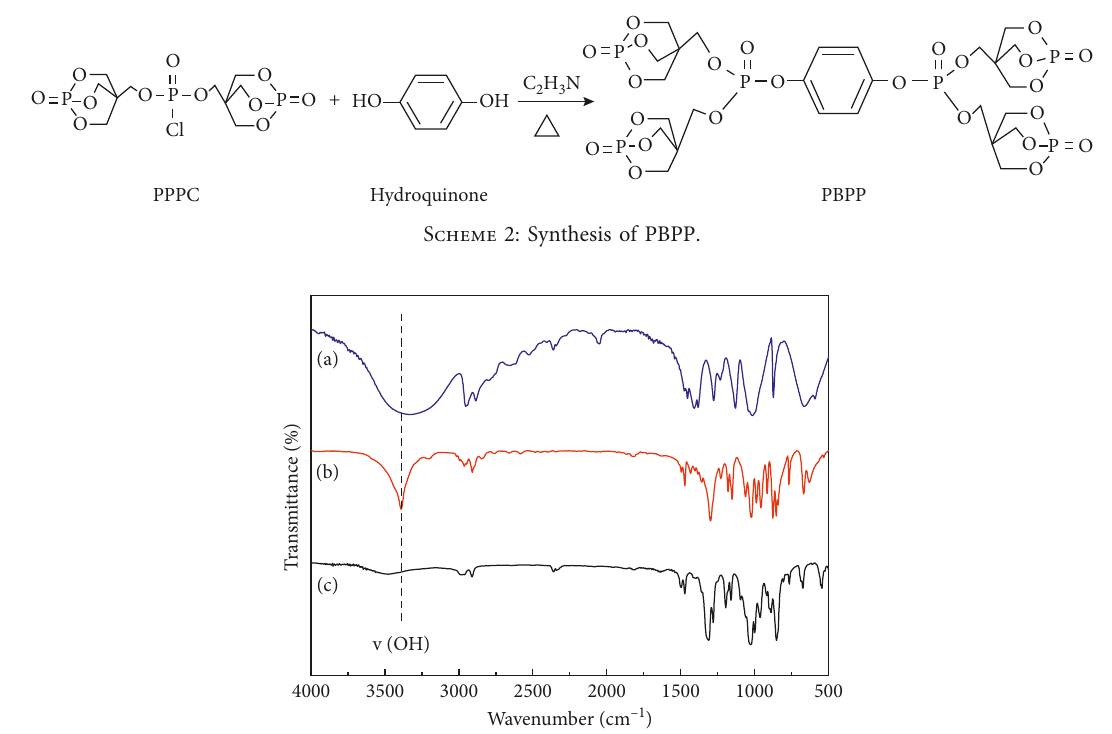
Figure 1: The FT-IR spectra of PER (a), PEPA (b), and PBPP (c).